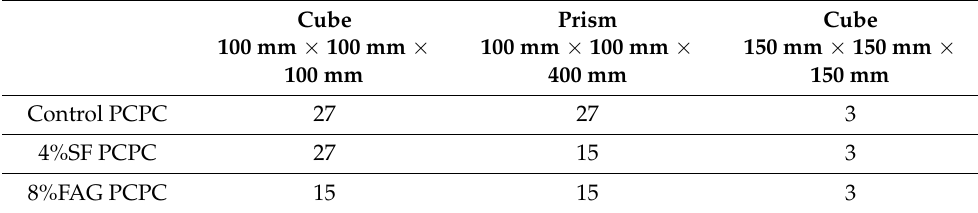
Table 3. The total number of the specimens in wet-dry cycles.